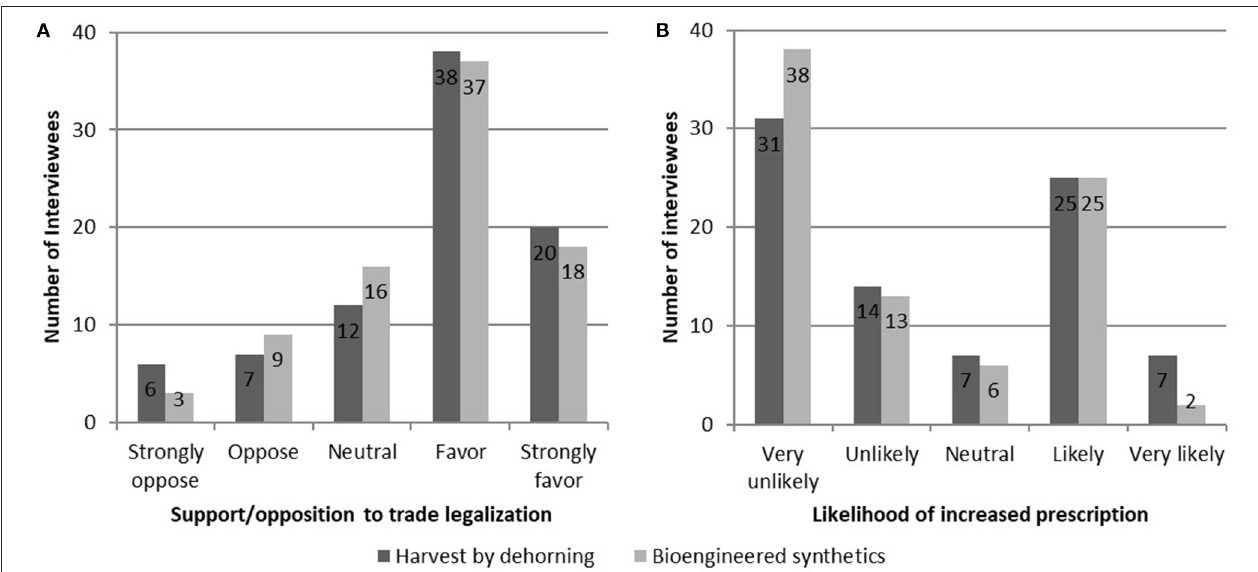
were legally available. A hierarchical multiple regression did